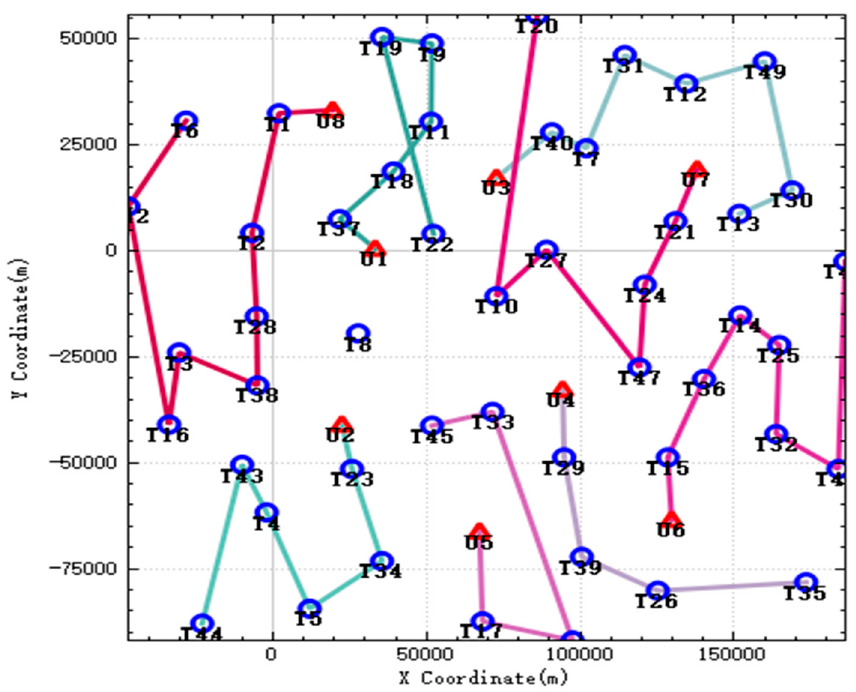
Figure 1. UAV mission route.